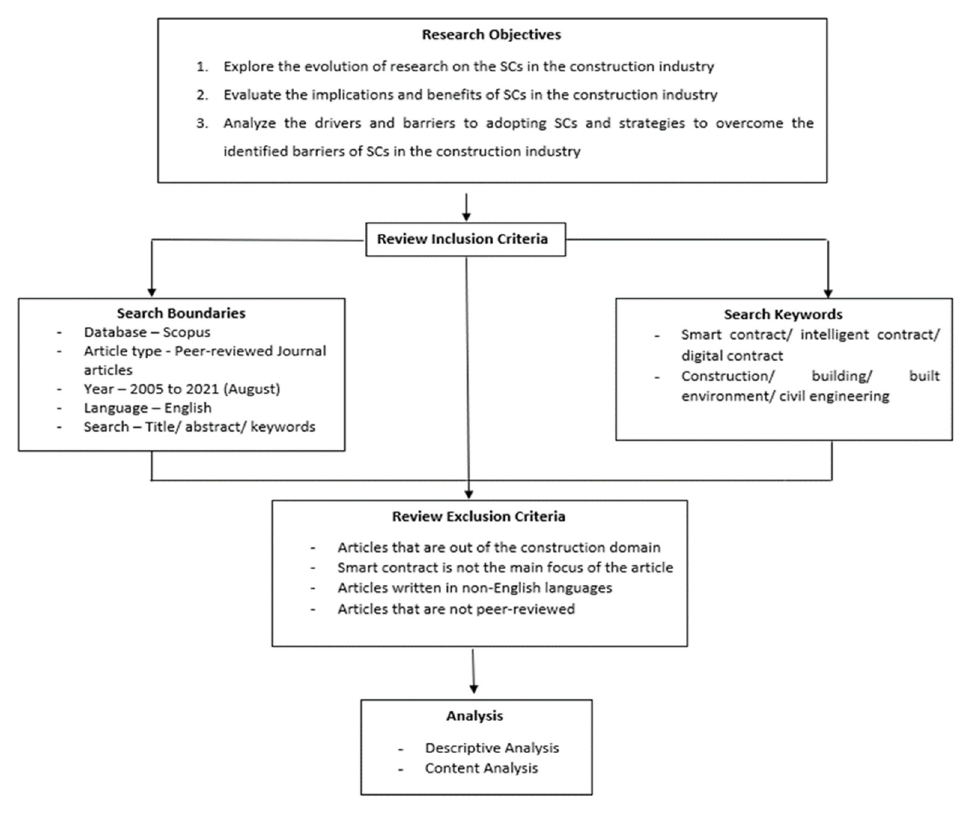
Figure 1. The process of SLR .